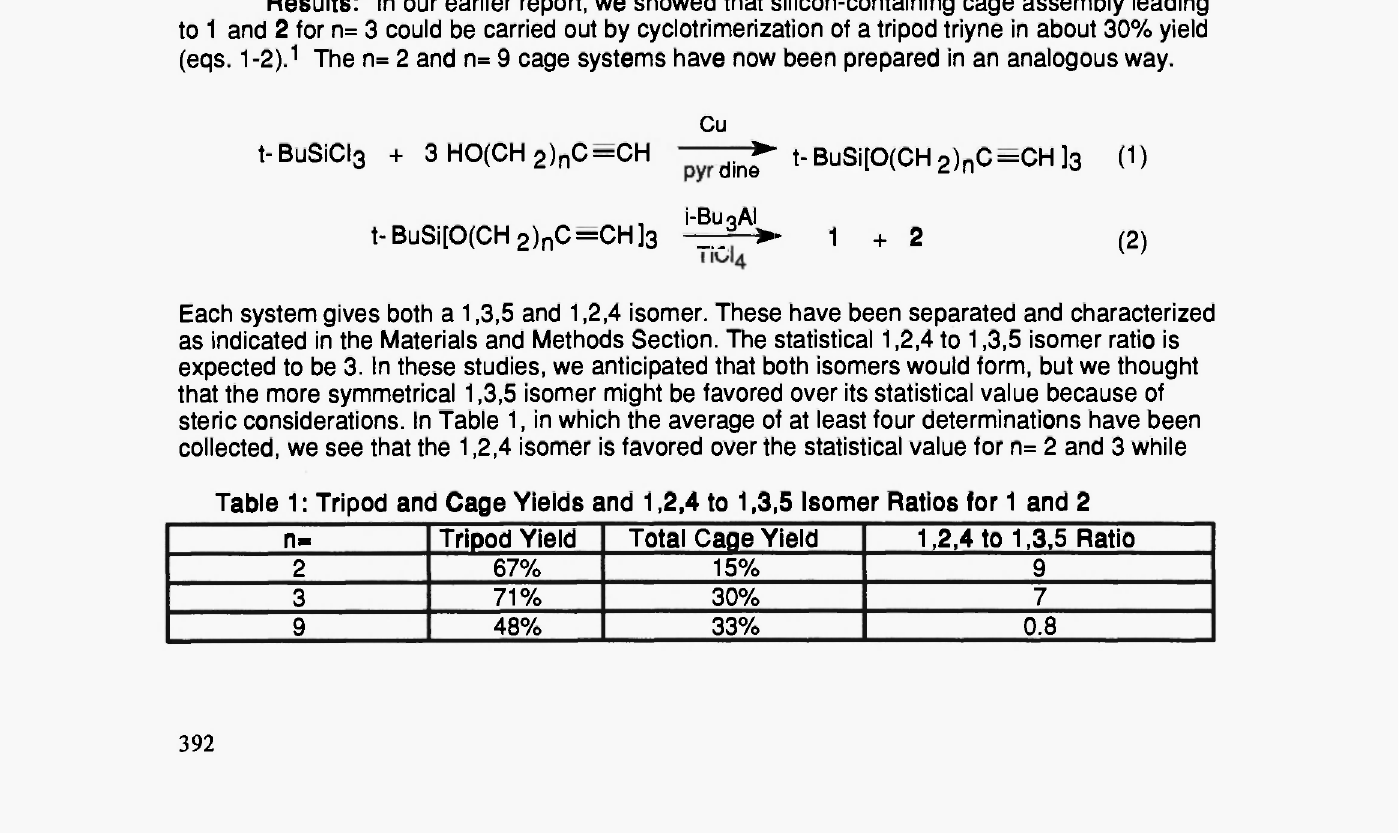
Table 1: Tripod and Cage Yields and 1,2,4 to 1,3,5 Isomer Ratios for 1 and